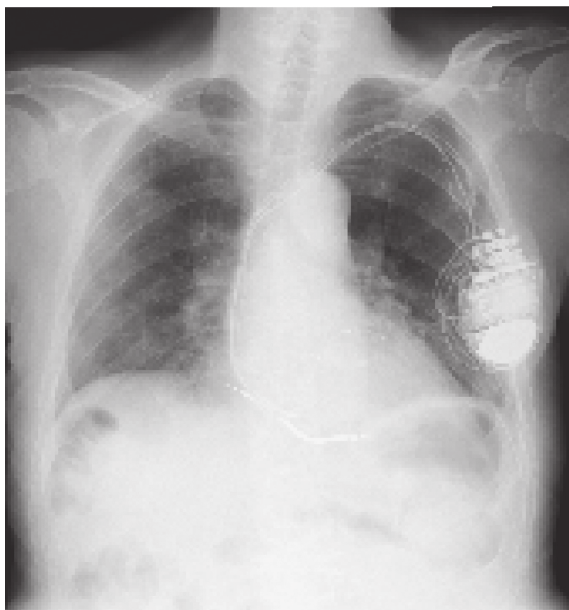
Figure 3: Chest X-ray one day after admission. The free air in the abdomen had